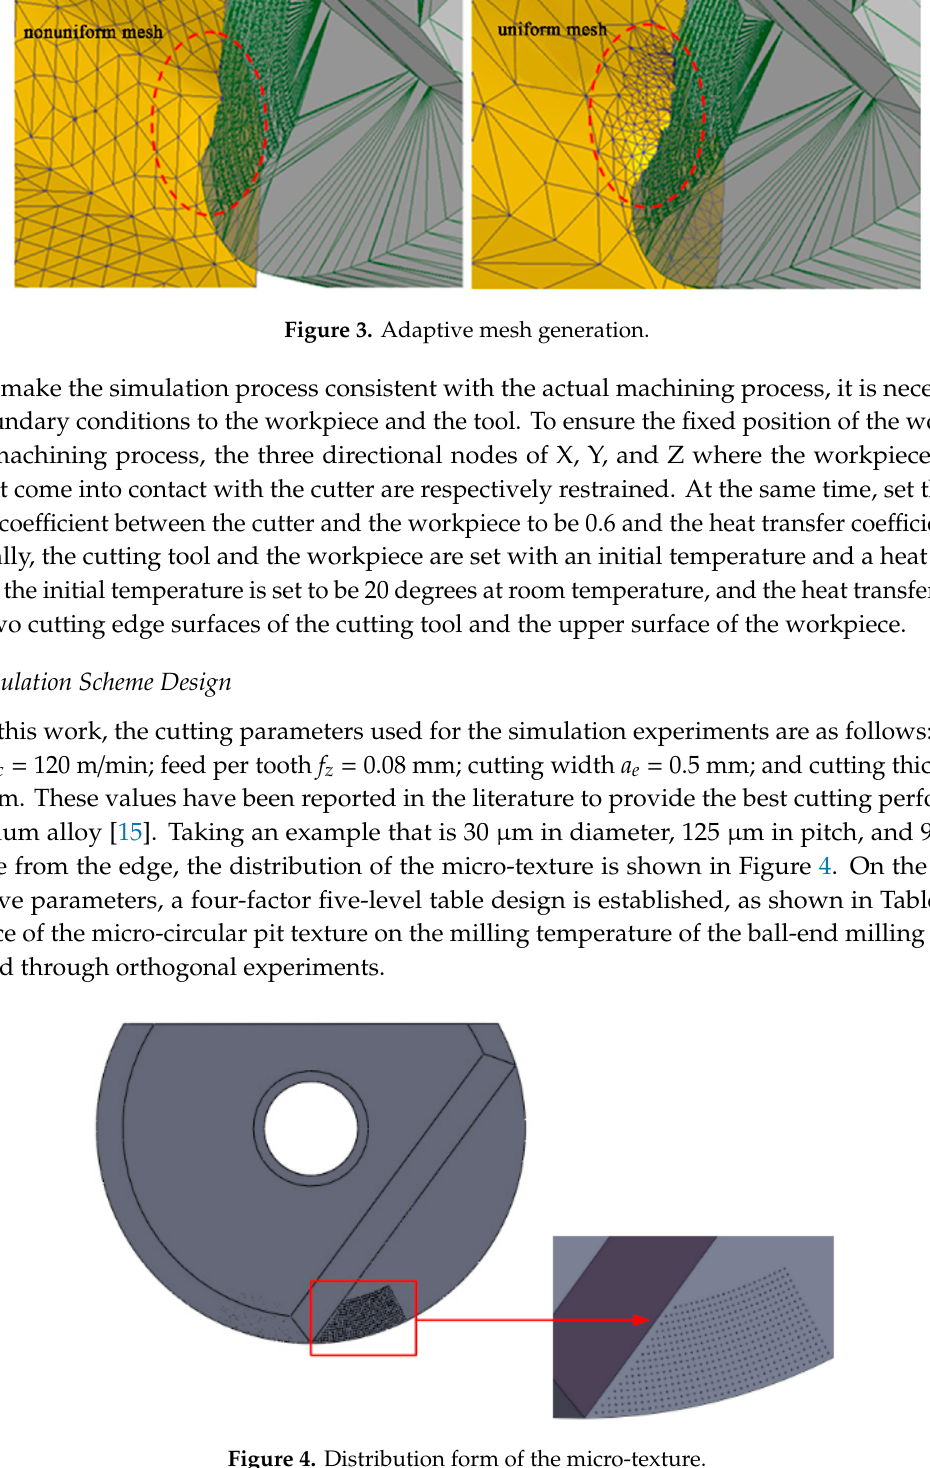
Figure 4. Distribution form of the micro-texture.